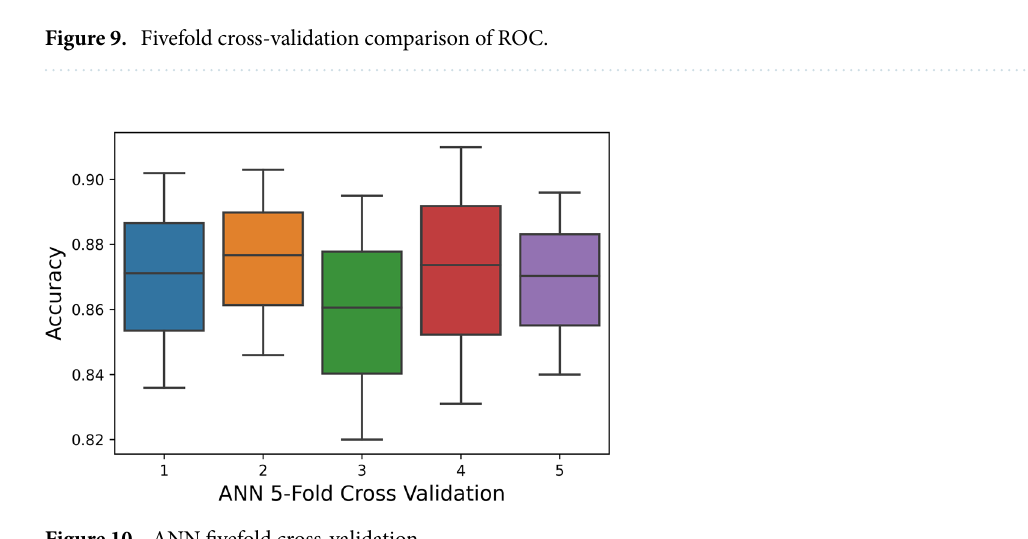
Figure 10. ANN fivefold